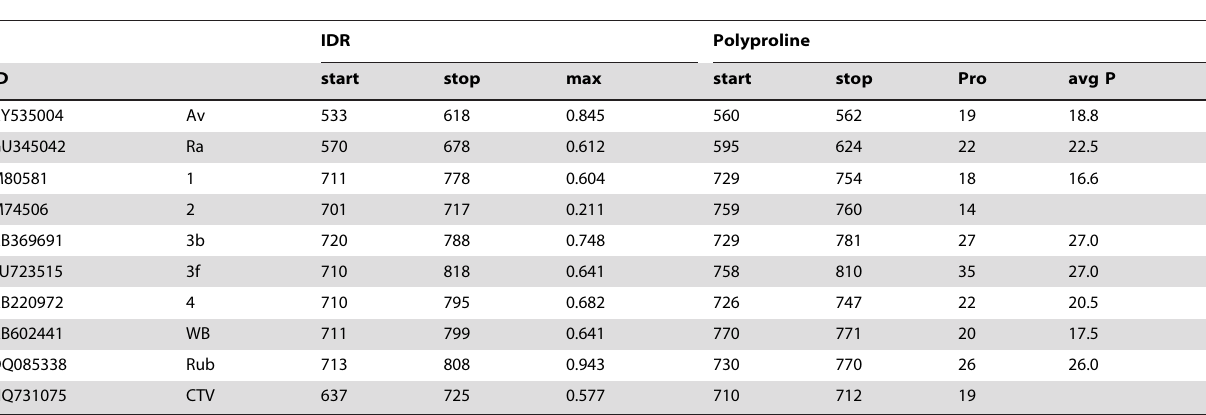
ID shows GenBank accession numbers for sequences used in the IDR calculation (DISOPRED2 [25]) and the polyproline sliding-window analysis. Class codes to right of each ID are: Av, avian; Ra, rat; genotype 1; genotype 2; subgenotype 3b; subgenotype 3f; genotype 4; WB, Japanese wild boar; Rub, rubivirus and CTV, cutthroat trout virus. The start and stop positions are those obtained from each calculation. Max is the maximum disorder probability in the PPR (threshold=0.05). Pro lists the number of prolines in each PPR IDR. Avg P is the average number of prolines in all members of a class. Empty avg P indicates presence of only a single member in that class.